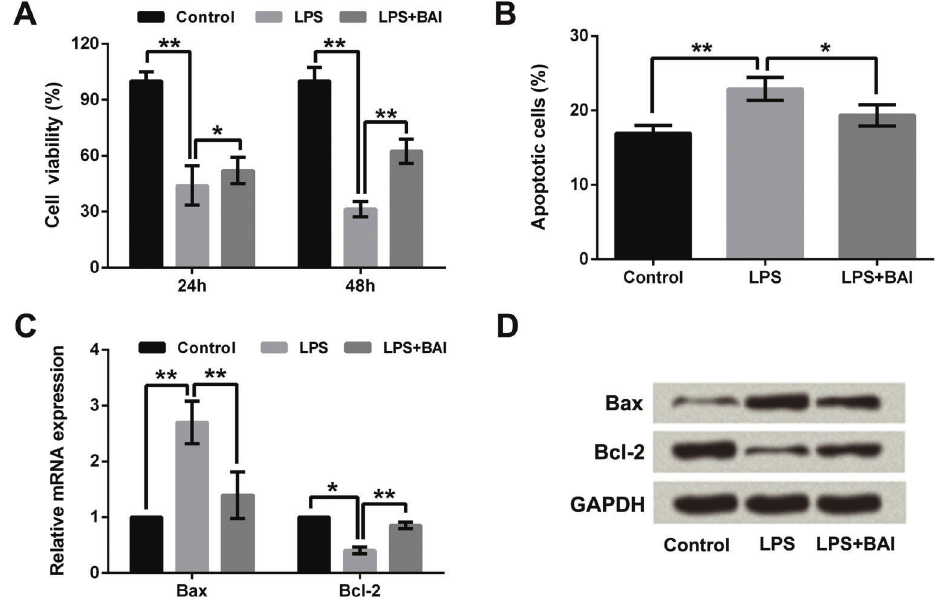
Figure 3. Effect of BAI on LPS-induced RPTECs. A , viability; B ; apoptosis; C , mRNA expression of Bax and Bcl-2. D , Bax and Bcl-2 results by western blotting. BAI: baicalein; LPS: lipopolysaccharide; RPTECs: renal proximal tubular epithelial cells. Data are reported as means ± SE. *P o 0.05; **P o 0.01